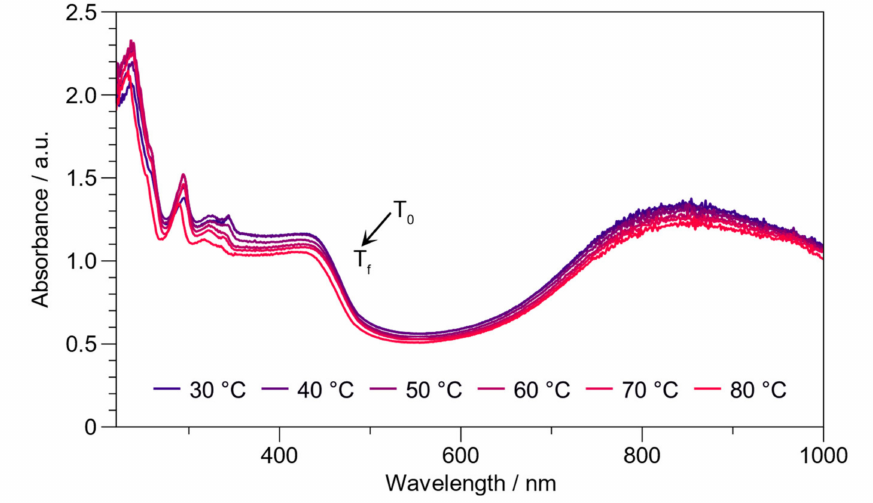
Figure 7. UV–Vis study of the BL PAni, dispersed in water, correlates with temperature from 30 to 80 ◦ C.